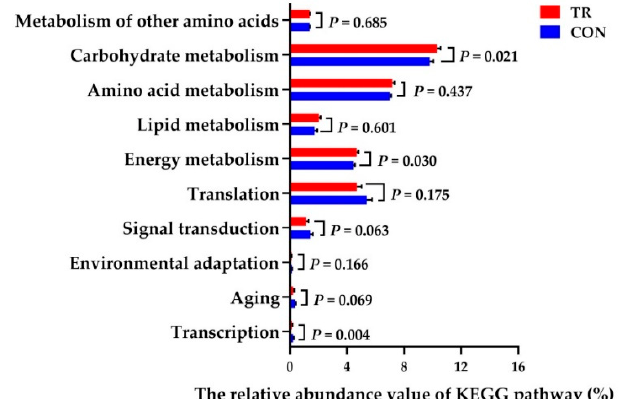
Figure 2. The relative abundance of the top-ten phylogenetic investigation of communities by reconstruction of unobserved states (PICRUSt)-predicted metabolic pathways of ruminal bacterial microbiome in CON and TR groups.